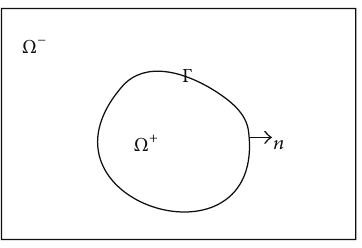
Figure 1: Domain Ω , its subdomains Ω + , Ω − , and interface Γ